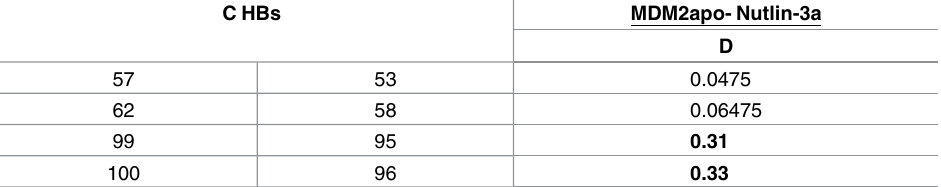
Table 2. D-values: Fraction of time the C-HBs of MDM2 are broken for Nutlin-3a-MDM2 complex (D- values represent averagesover four different replicas). The C-BHs are indicatedby the numbers of the pair of residues involvedin the hydrogen